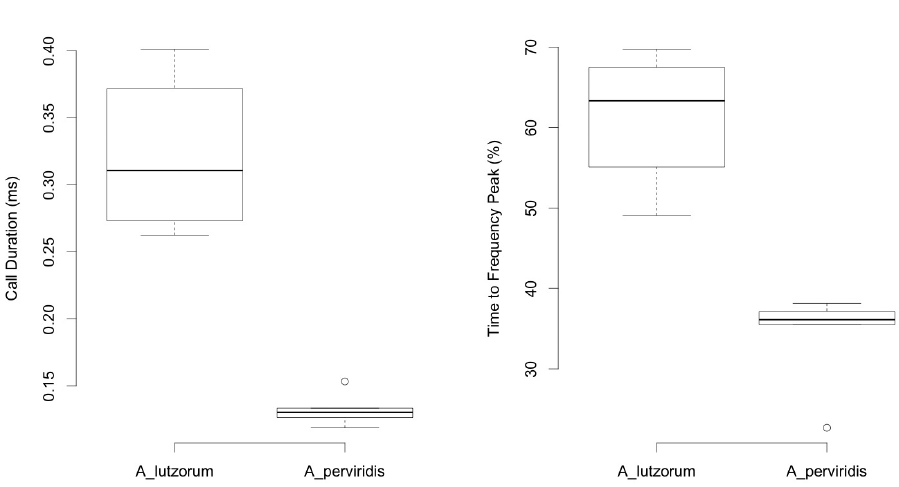
Figure 4. A comparison between duration and frequency peak time of Aplastodiscus lutzorum (N = 12 males) and A. perviridis (N = 5 males). In both samples, calls are of